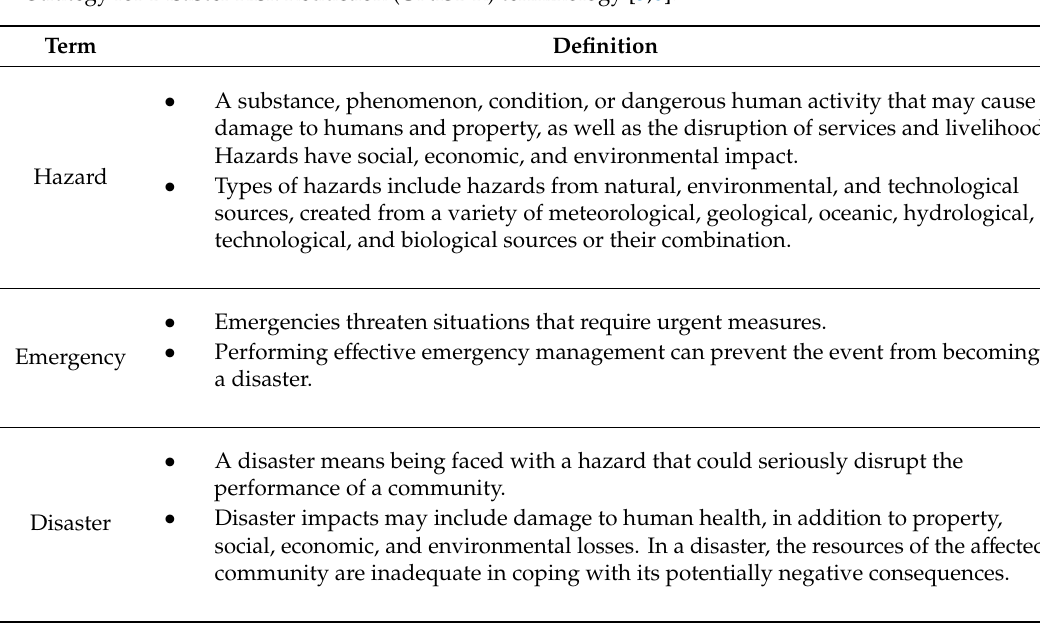
Table 1. Definitions of hazard, emergency, and disaster based on the United Nations International Strategy for Disaster Risk Reduction (UNISDR) terminology